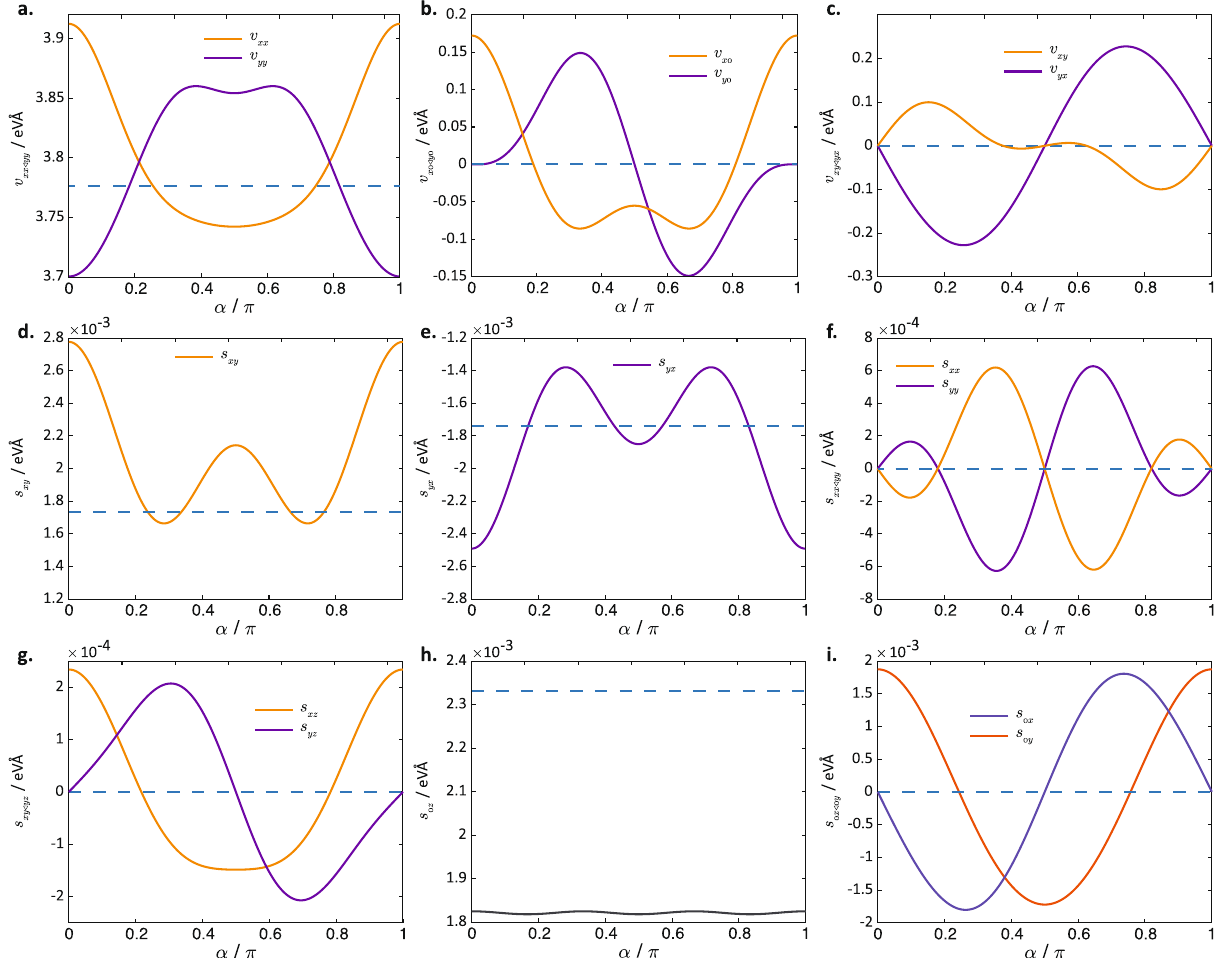
Figure 4. The values of the various Hamiltonian parameters for strained silicene with γ = 1.1 as a function of the strain angle α in Eq. (29) where for j ∈ ( x , y ) , ¯ j �= j . The dotted lines in each plot shows the values of the quantities plotted in unstrained silicene. ( a ) v jj , ( b ) v ji , ( c ) v j ¯ i , ( d ) s xy , ( e ) s yx , ( f ) s jj , ( g ) s jz , ( h ) s 0 z , ( i ) s 0 j